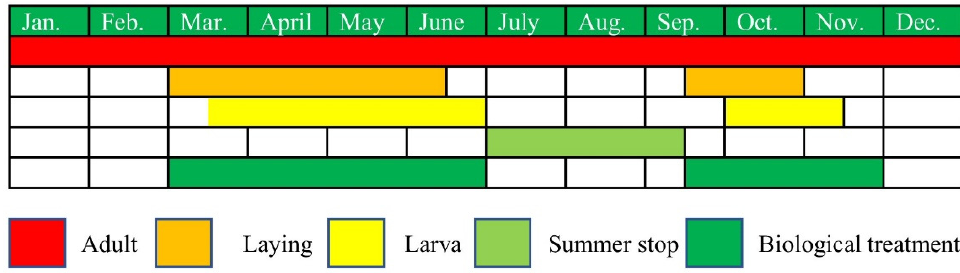
Figure 2. Diagram of the snout beetle life cycle.